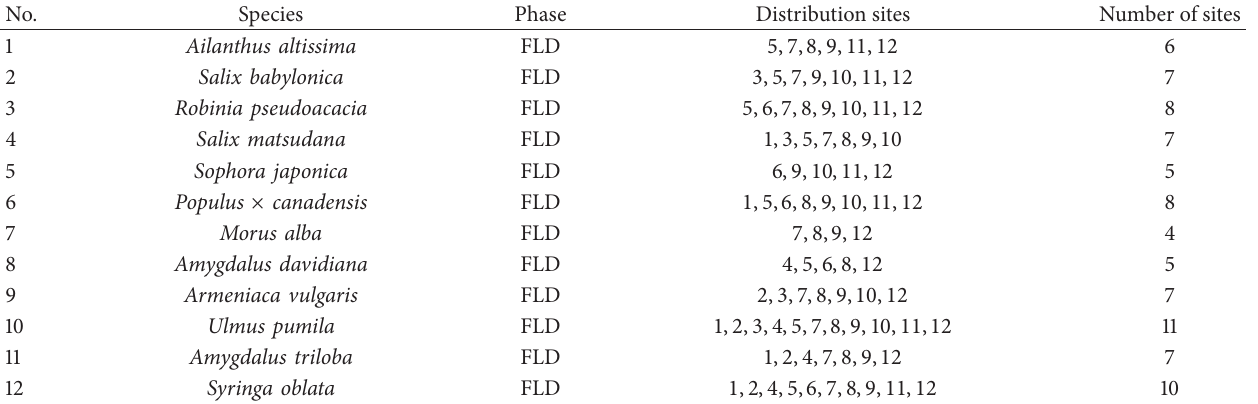
Table 1: Study species and their distribution sites with first leaf date (FLD) data. The number of sites for each species is defined in Figure 1.